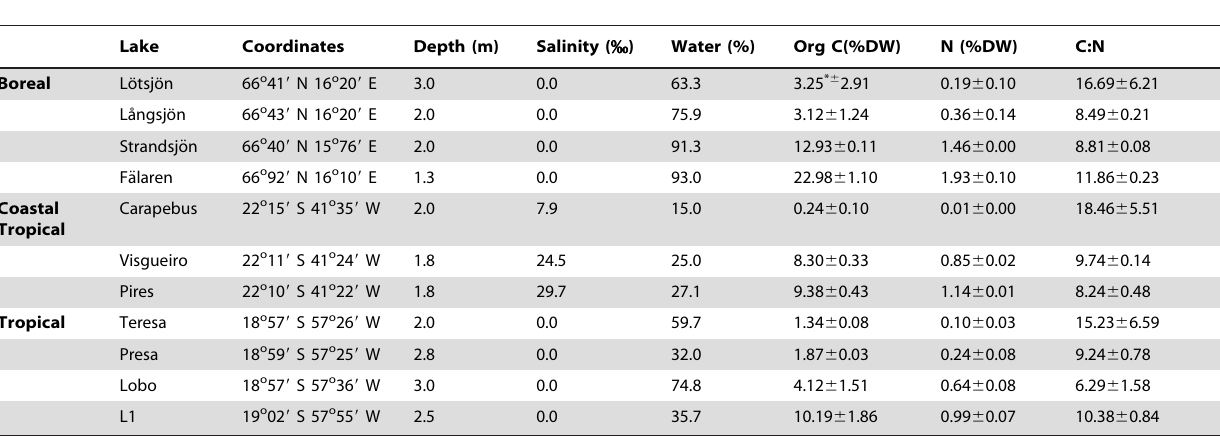
Table 1. Coordinates, sample site depth, water salinity, and sediment contents (% of dry weight) of water, sediment organic carbon and nitrogen content, and C:N ratio at the studied